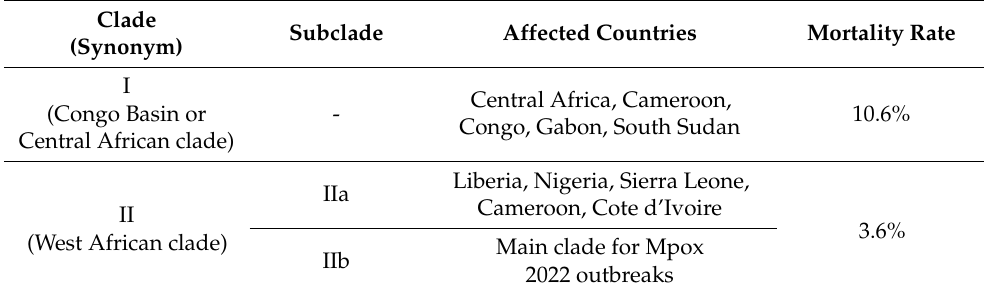
Subclade Affected Countries Mortality Rate